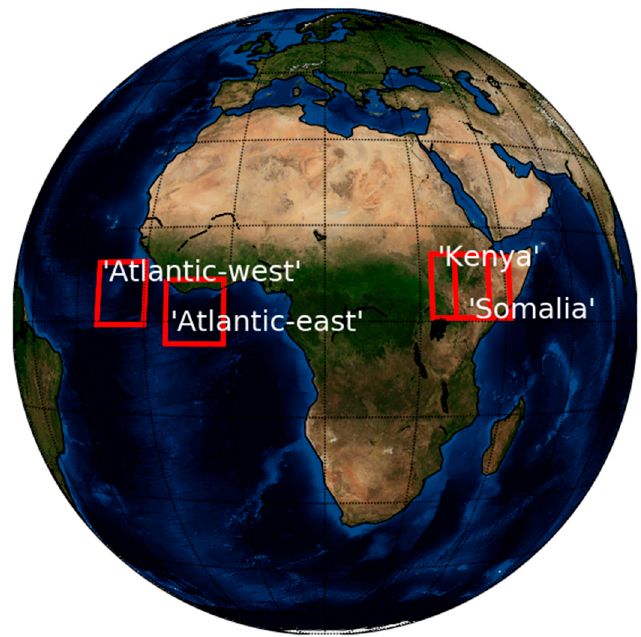
Figure 7. Locations of the areas considered for finding potentially ray-matched SCIAMACHY-MVIRI collocations (Zero Degree Mission (ZDM) and Indian Ocean data coverage (IODC)) that are exploited in this study. The collocation results for each area are presented in Figure 16.